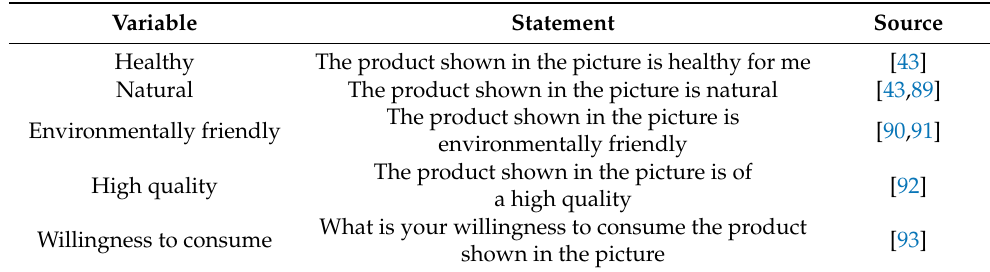
Table A1. Survey